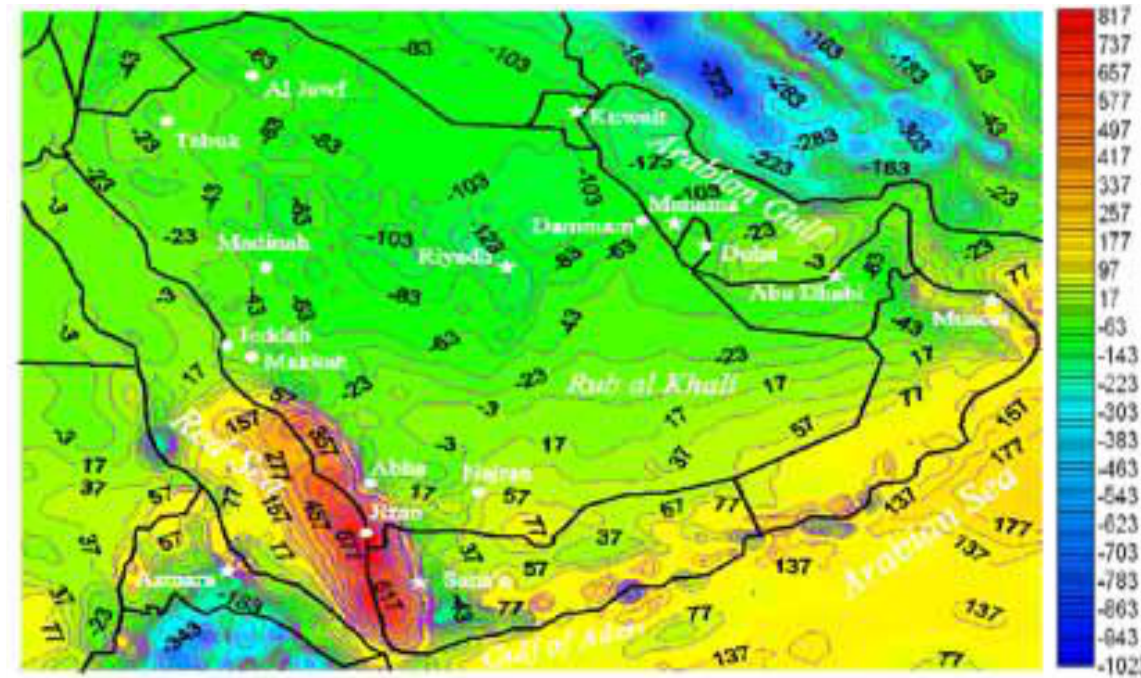
Figure 20. Annual Total Precipitation Change from 2070 to 2100 (mm/yr)